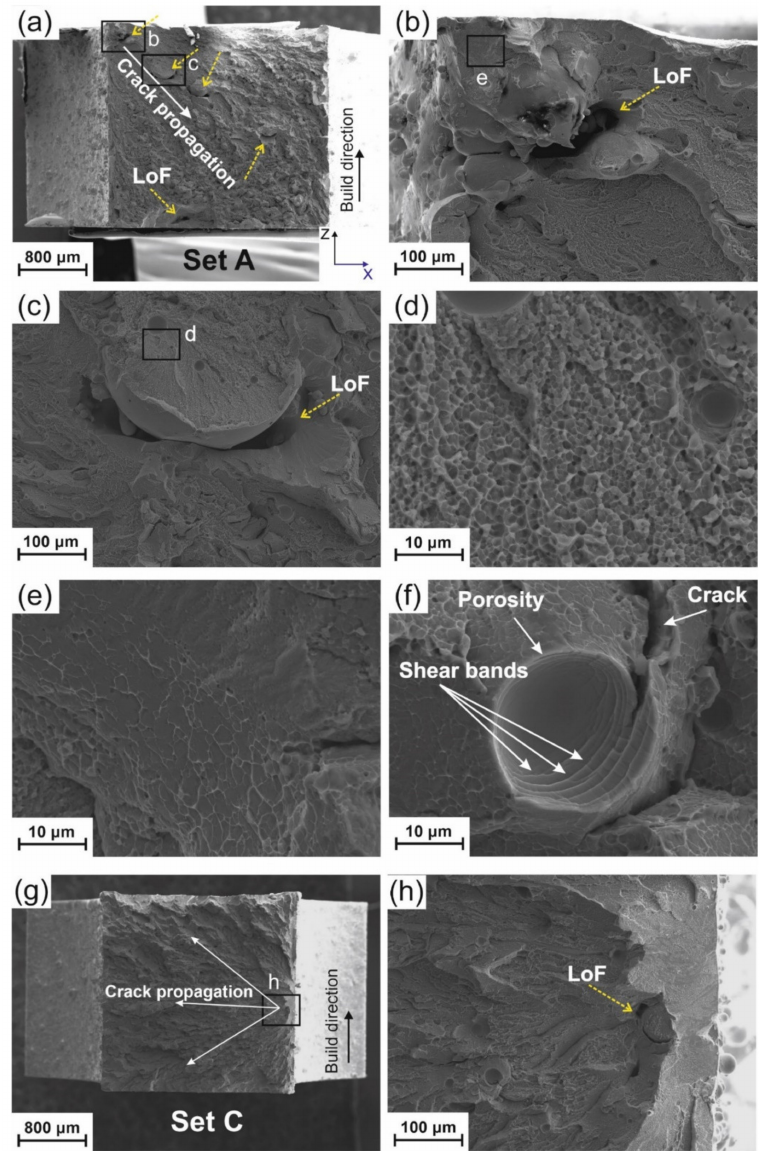
Figure 6. ( a ) Fracture surface (X-Z plane) of a tensile specimen Set A after rupture. Yellow-dashed arrows show LoFs. ( b ) Region b in ( a ) with a higher magnification showing the start of failure from a lack of fusion (LoF), ( c ) region c in ( a ) with a higher magnification indicating another LoF, ( d ) region d in ( c ) with a higher magnification showing dimple-like features, ( e ) region e in ( b ) with a higher magnification indicating vein-like patterns, ( f ) a porosity arrests a crack and multiple shear bands are found, ( g ) fracture surface (X-Z plane) of a tensile specimen C, and ( h ) region h shown in ( g ) with a higher